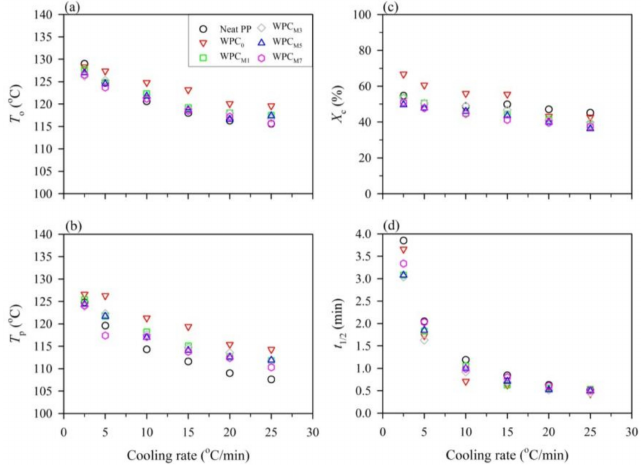
Figure 2. Non-isothermal crystallization parameters as a function of the cooling rate for the neat PP and wood–plastic composites (WPCs) with various maleated polypropylene (MAPP) concentrations. ( a ) The onset temperature ( T o ); ( b ) The crystallization peak ( T p ); ( c ) Crystallinity ( X c ); ( d ) The half-time ( t 1/2